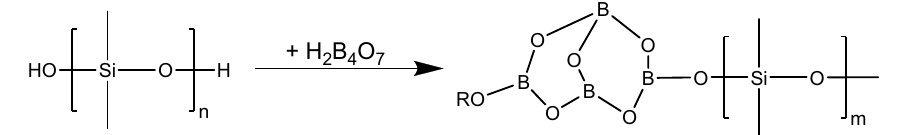
Figure 1. H 2 B 4 O 7 insertion into PDMS polymeric backbone.